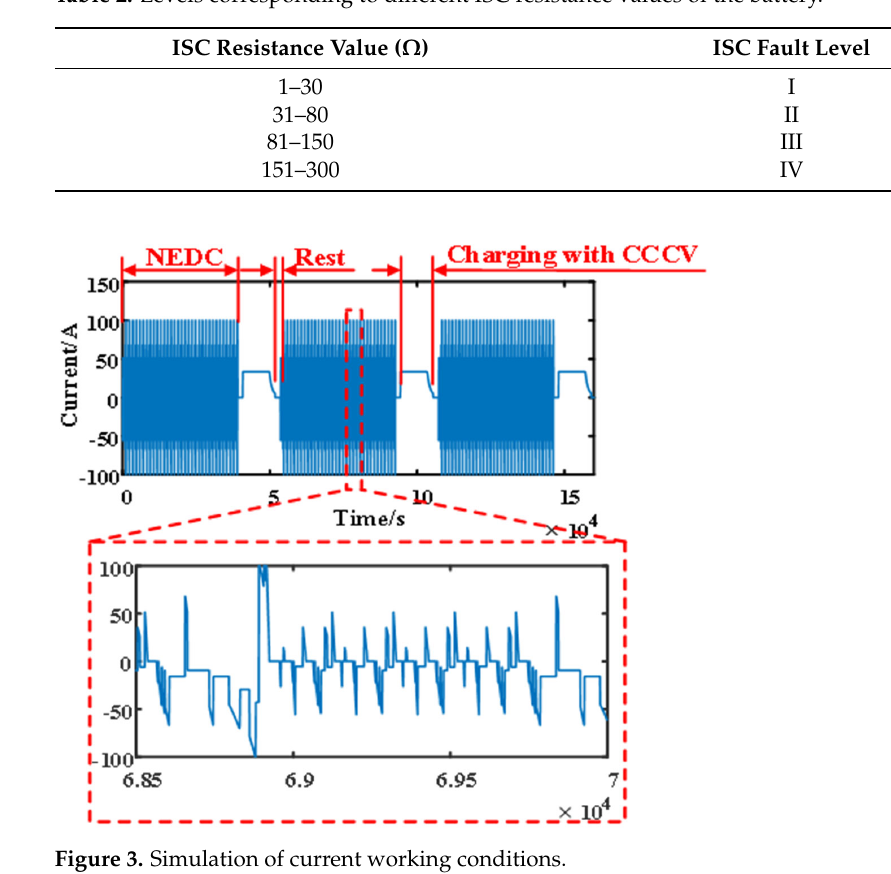
Figure 3. Simulation of current working conditions.